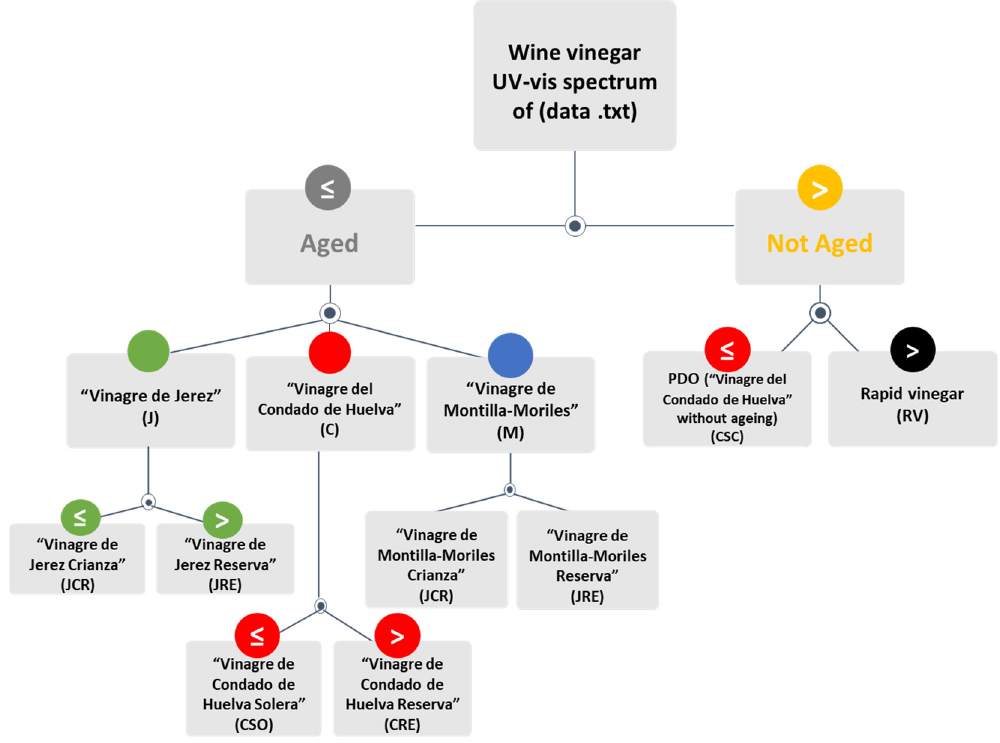
Figure 1. Diagram of the hierarchical classification model (HCM) followed for the development of the decision tree included in the tool.